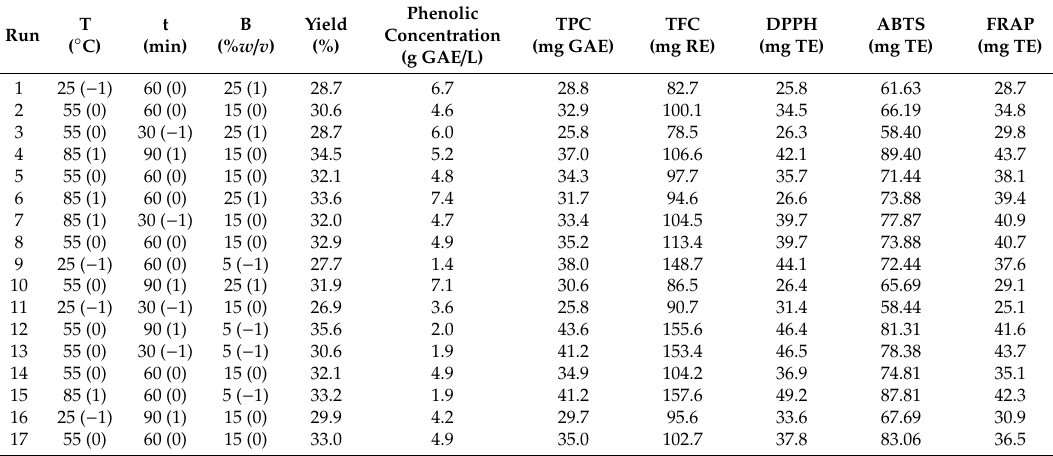
Table 3. Box–Benhken experimental design in terms of actual and coded factors applied to the aqueous extraction conditions and experimental values of the response variables. Antioxidant capacity indicators are expressed per gram of EOP.